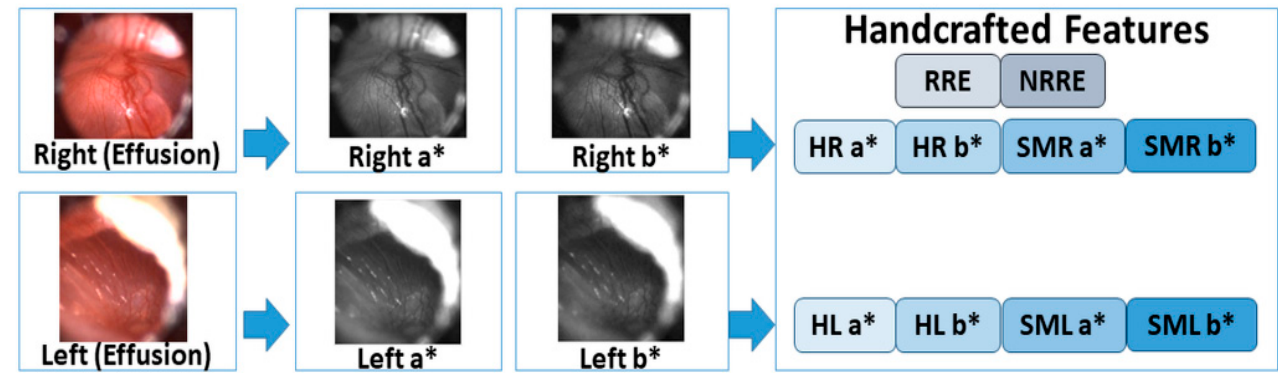
Figure 3. Creation of a feature vector structure for a pair of eardrum images. Rigid and Non-Rigid registration errors were calculated for a pair of eardrums. RGB pair images are converted to the L*a*b* color space, and a* and b* components are used for creating color histograms and calculating statistical measurements. All features are concatenated to form a handcrafted feature vector. RRE: Rigid Registration Error, NRRE: Non-Rigid Registration Error, HR a*: Histogram of Right a*, HR b*: Histogram of Right b*, HL a*: Histogram of Left a*, HL b*: Histogram of Left b*, SMR a*: Statistical Measurements of Right a*, SMR b*: Statistical Measurements of Right b*, SML a*: Statistical Measurements of Left a*, SML b*: Statistical Measurements of Left b*.